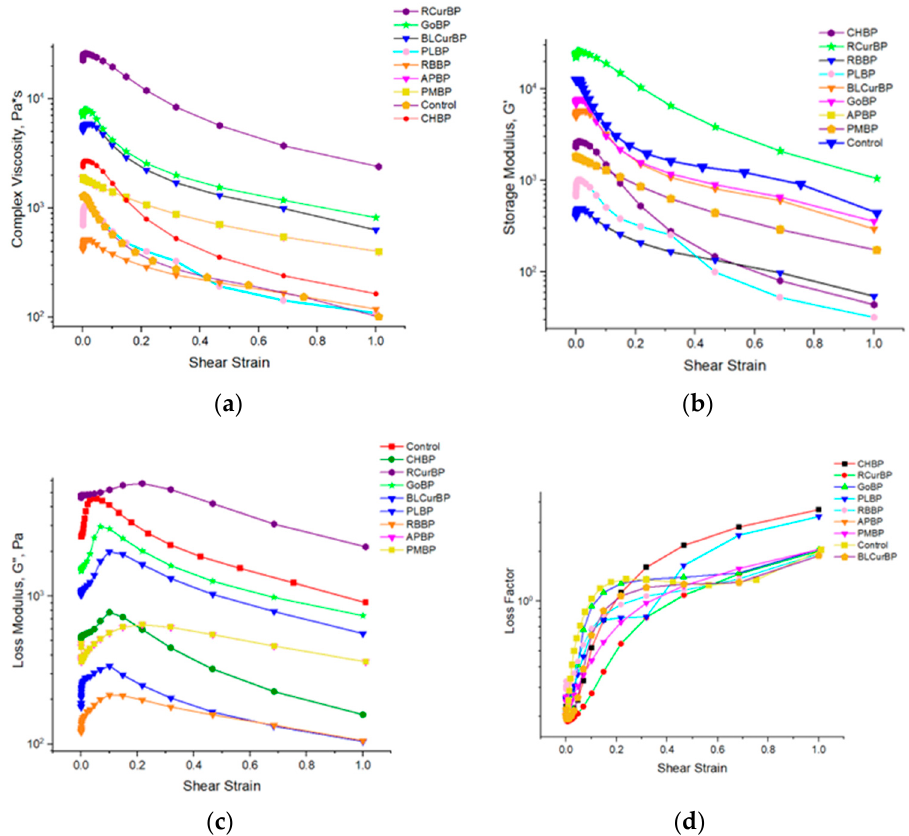
Figure 5. Rheological behavior of pectin gels: ( a ) complex viscosity of gels; ( b ) storage modulus of gels; ( c ) loss modulus of gels; ( d ) loss factor of pectin gels.